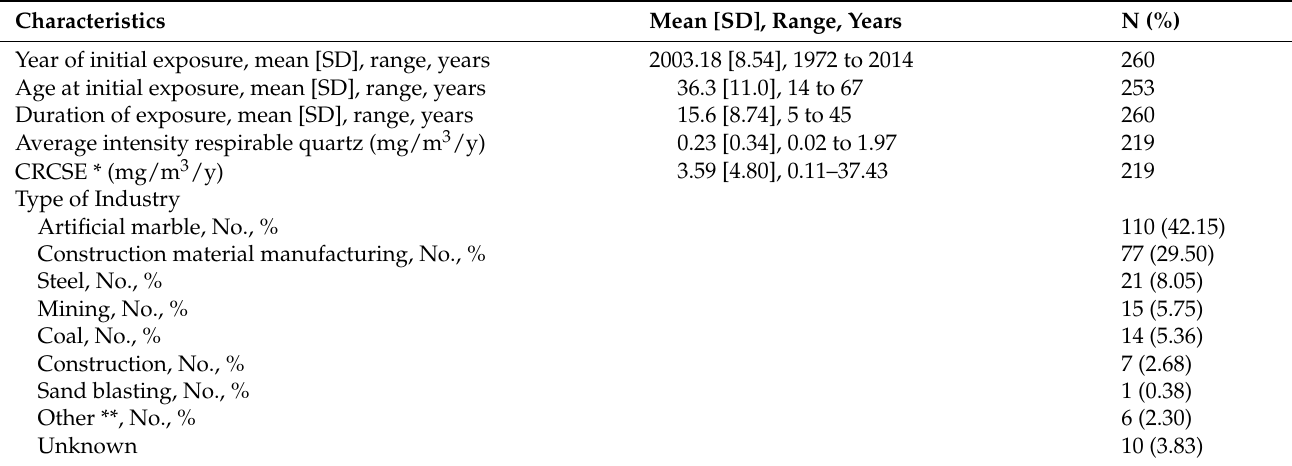
Table 2. Employment characteristics of the